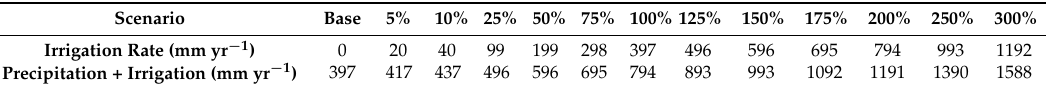
Table 1. Total yearly irrigation and irrigation plus precipitation rates for all simulations. Irrigation